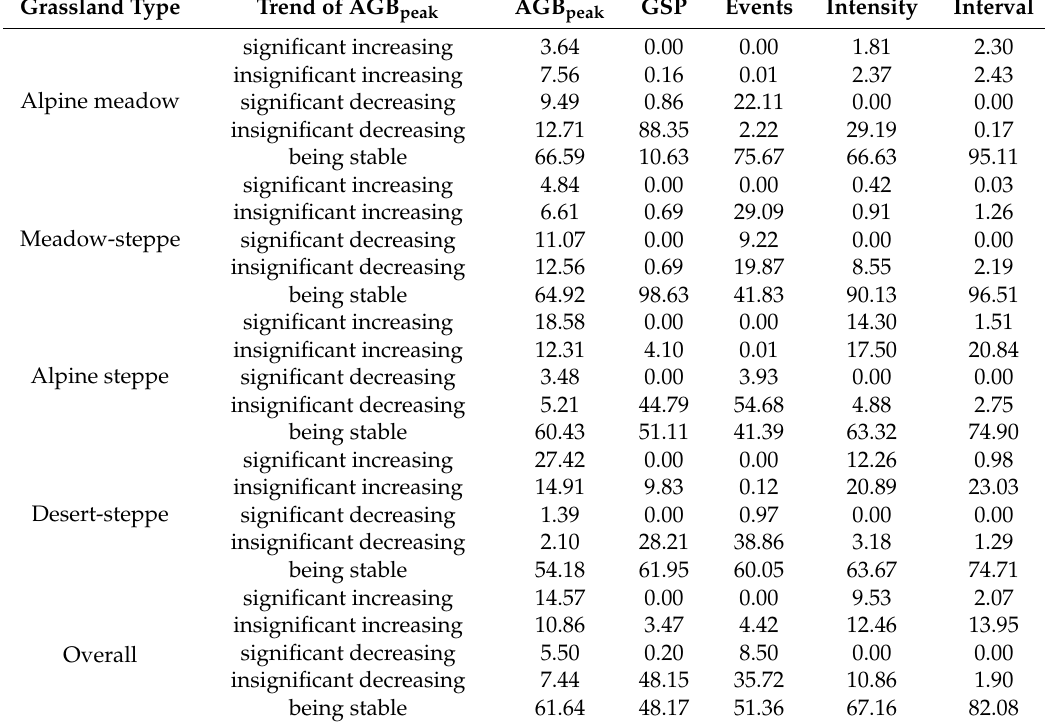
Table 4. Percentage of pixels showing different trends in the peak aboveground biomass (AGB peak ), growing season precipitation (GSP), number of precipitation events (Events), mean intensity of precipitation events (Intensity), and time interval between precipitation events (Intervals), either significantly or non-significantly at α = 0.05 significance level within each type of alpine grasslands on the northern Tibetan